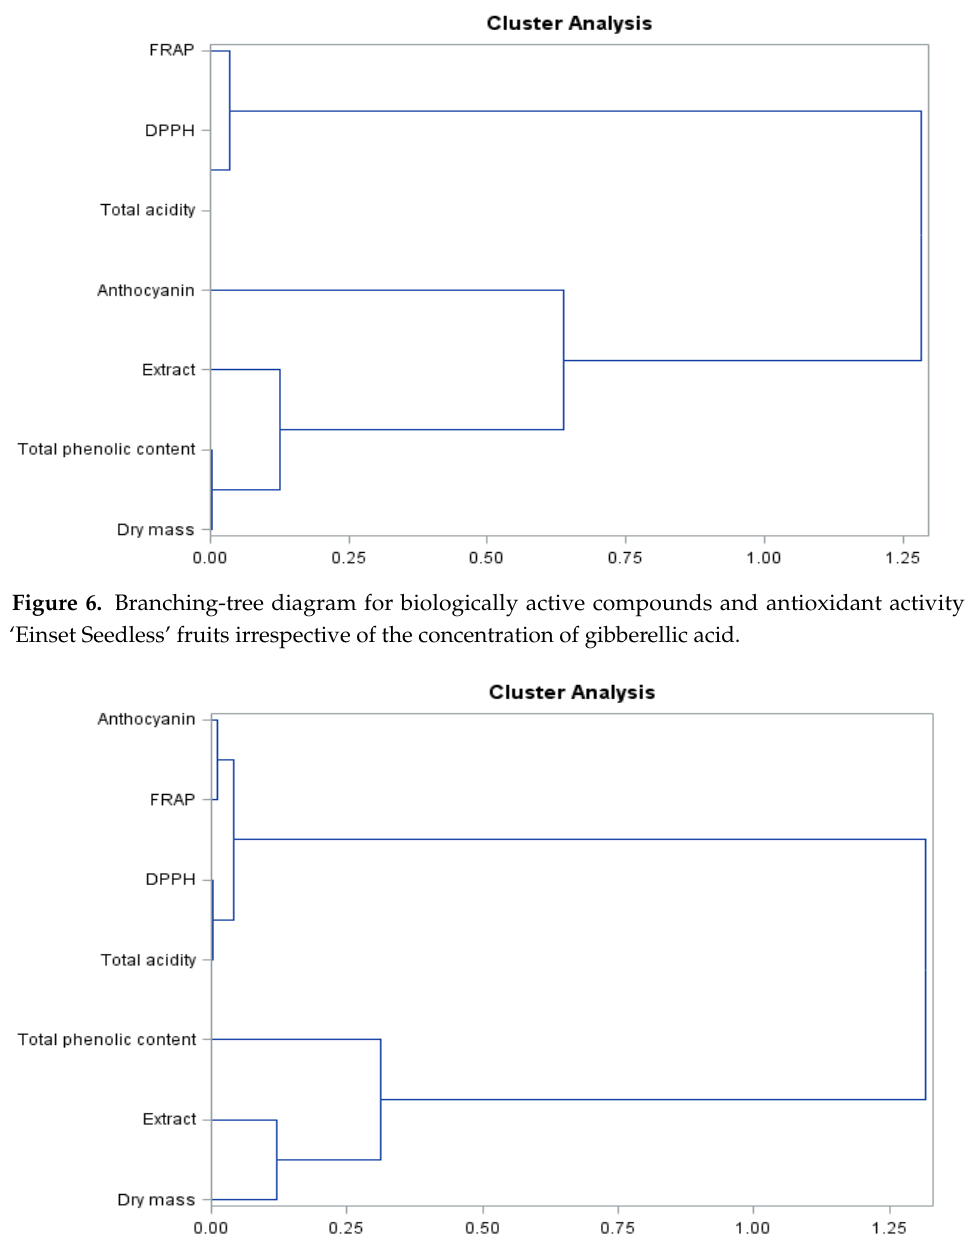
Figure 7. Branching-tree diagram for biologically active compounds and antioxidant activity of ‘Einset Seedless’ raisins regardless of the concentration of gibberellic acid.